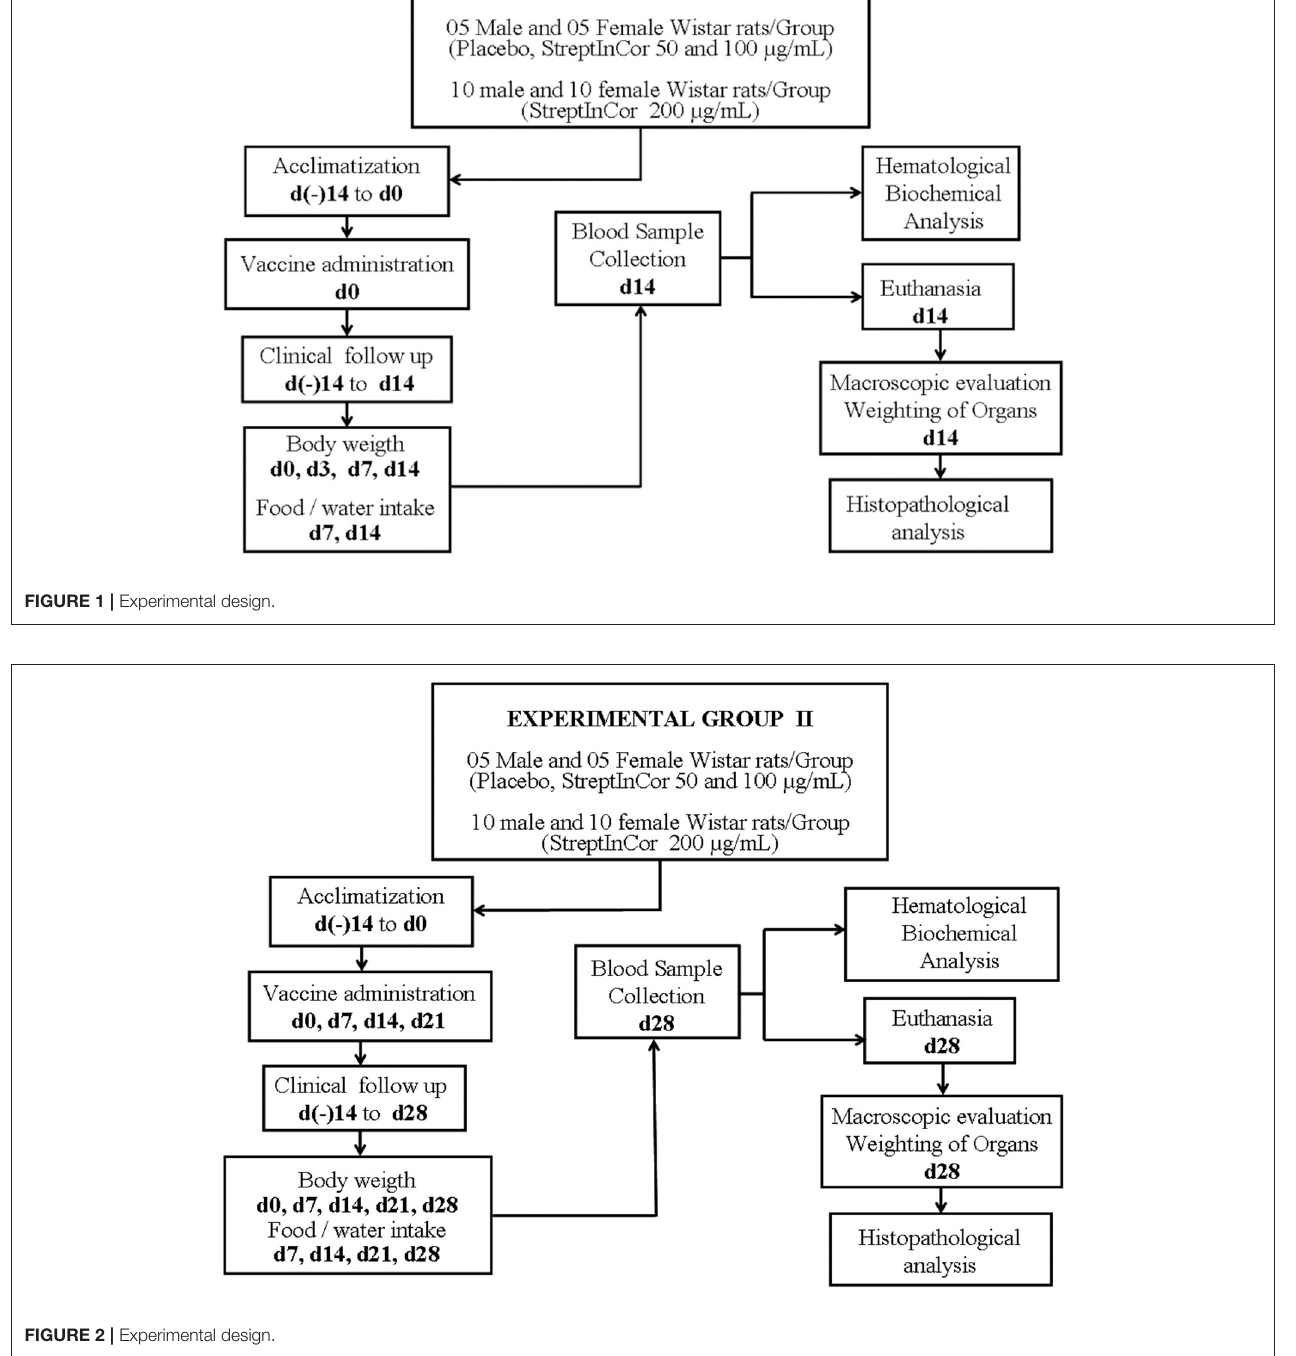
FIGURE 2 | Experimental